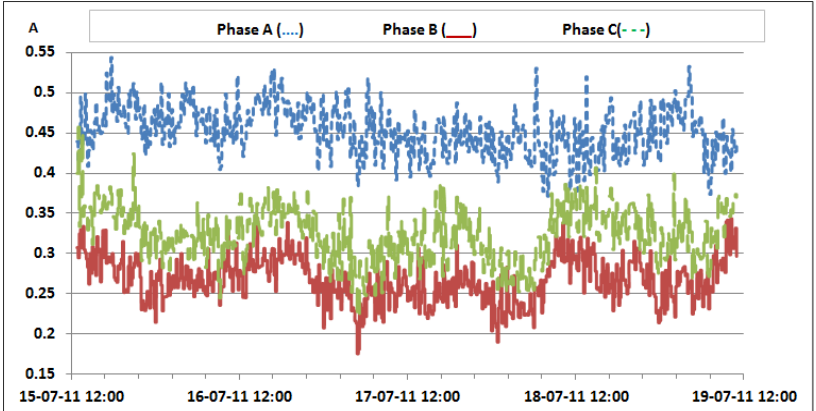
Figure 24. TRMS values of 7th electric current harmonic measured on the individual